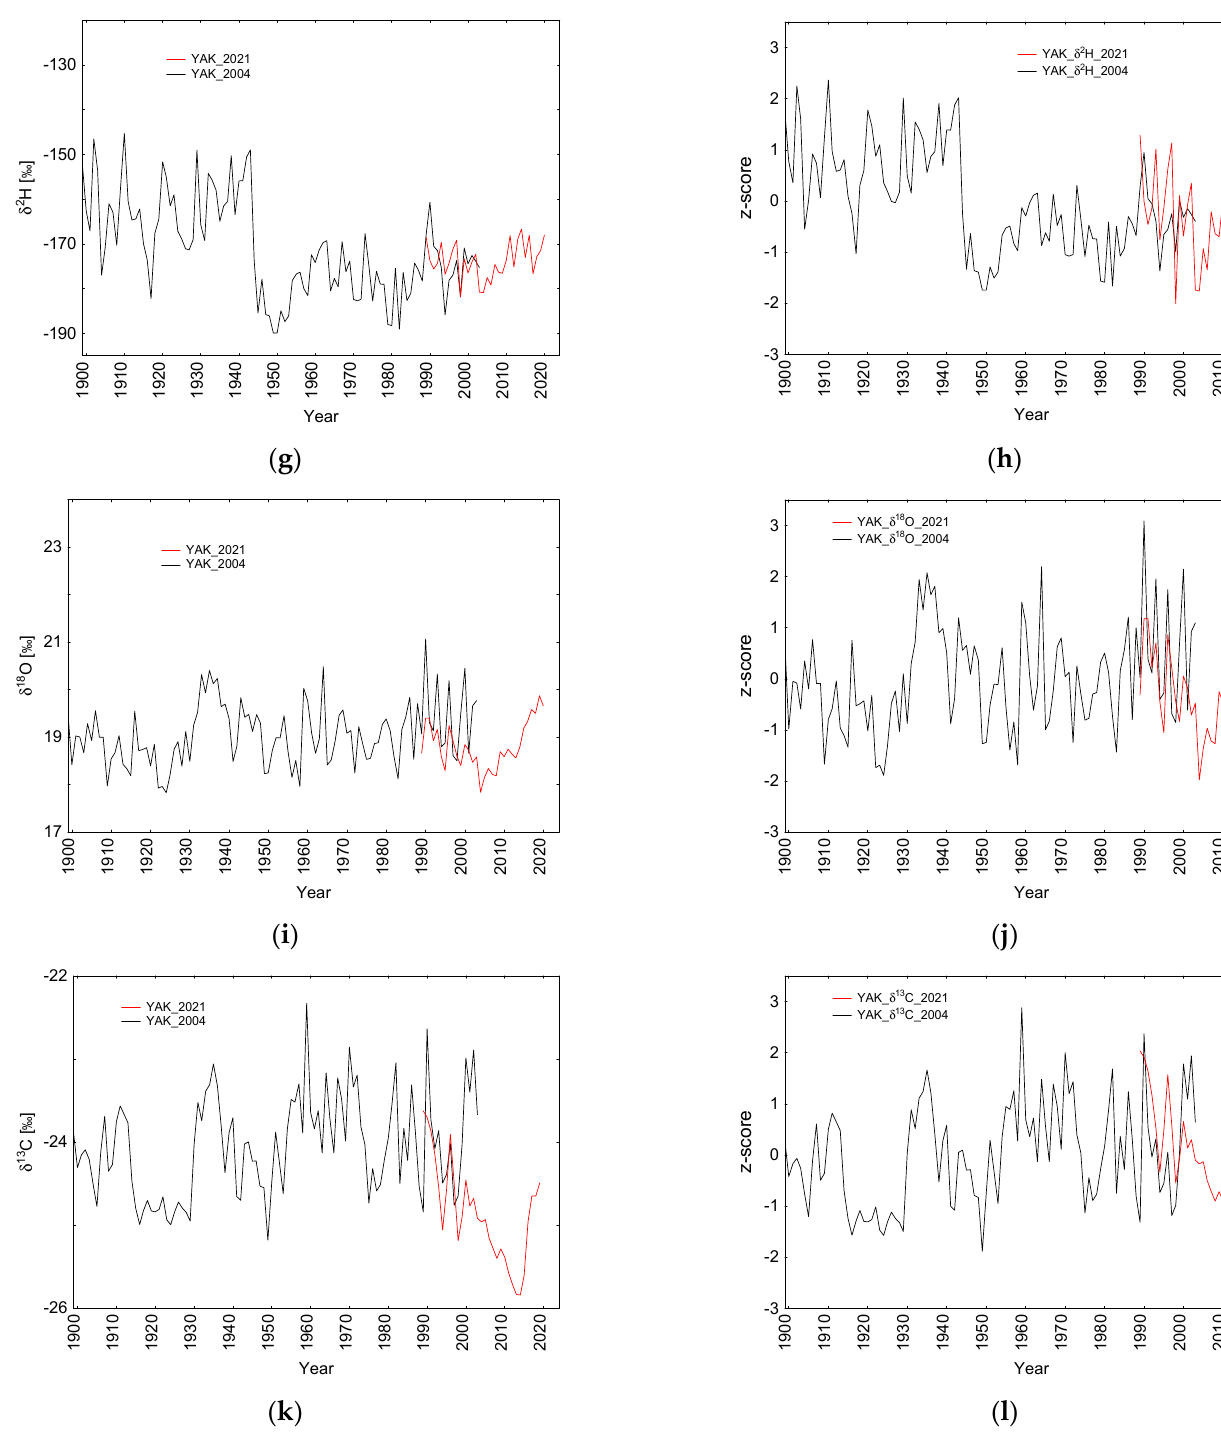
Figure 2. Stable hydrogen ( δ 2 H) ( a – g ), oxygen ( δ 18 O) ( c – i ) and carbon ( δ 13 C) ( e – k) isotope chronolo- gies and normalised (z-score) data ( b , d , f , h , j , l ) obtained from Kotuy, Taimyr (TAY), and Deputatsky, Yakutia (YAK), during the period from 1990–2020 and 1990–2021, respectively. Newly added (red) and normalised data obtained in comparison with earlier published data (black) stable isotope chronologies in tree-ring cellulose obtained from Kotuy, Taimyr (TAY), for the period from 1900 to 2009 [24] and from Indigirka, northeastern Yakutia (YAK), from 1900 to 2004 [20,25]. Considering the merged total chronologies, we found drastic changes in δ 2 H values around the 1950s for YAK with a slight tendency to increase towards the year 2021. Clearly higher δ 18 O values are recorded for TAY (Figure 2c) compared to a lower value in YAK (Figure 2i). The δ 13 C data show a decreasing trend towards the 21st century for both the TAY (Figure 2e) and YAK sites, with a more pronounced and drastic decrease for YAK (Figure 2k).